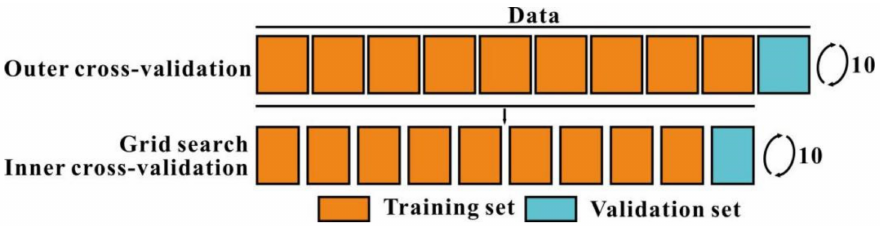
Figure 3. The schematic diagram indicating inner and outer